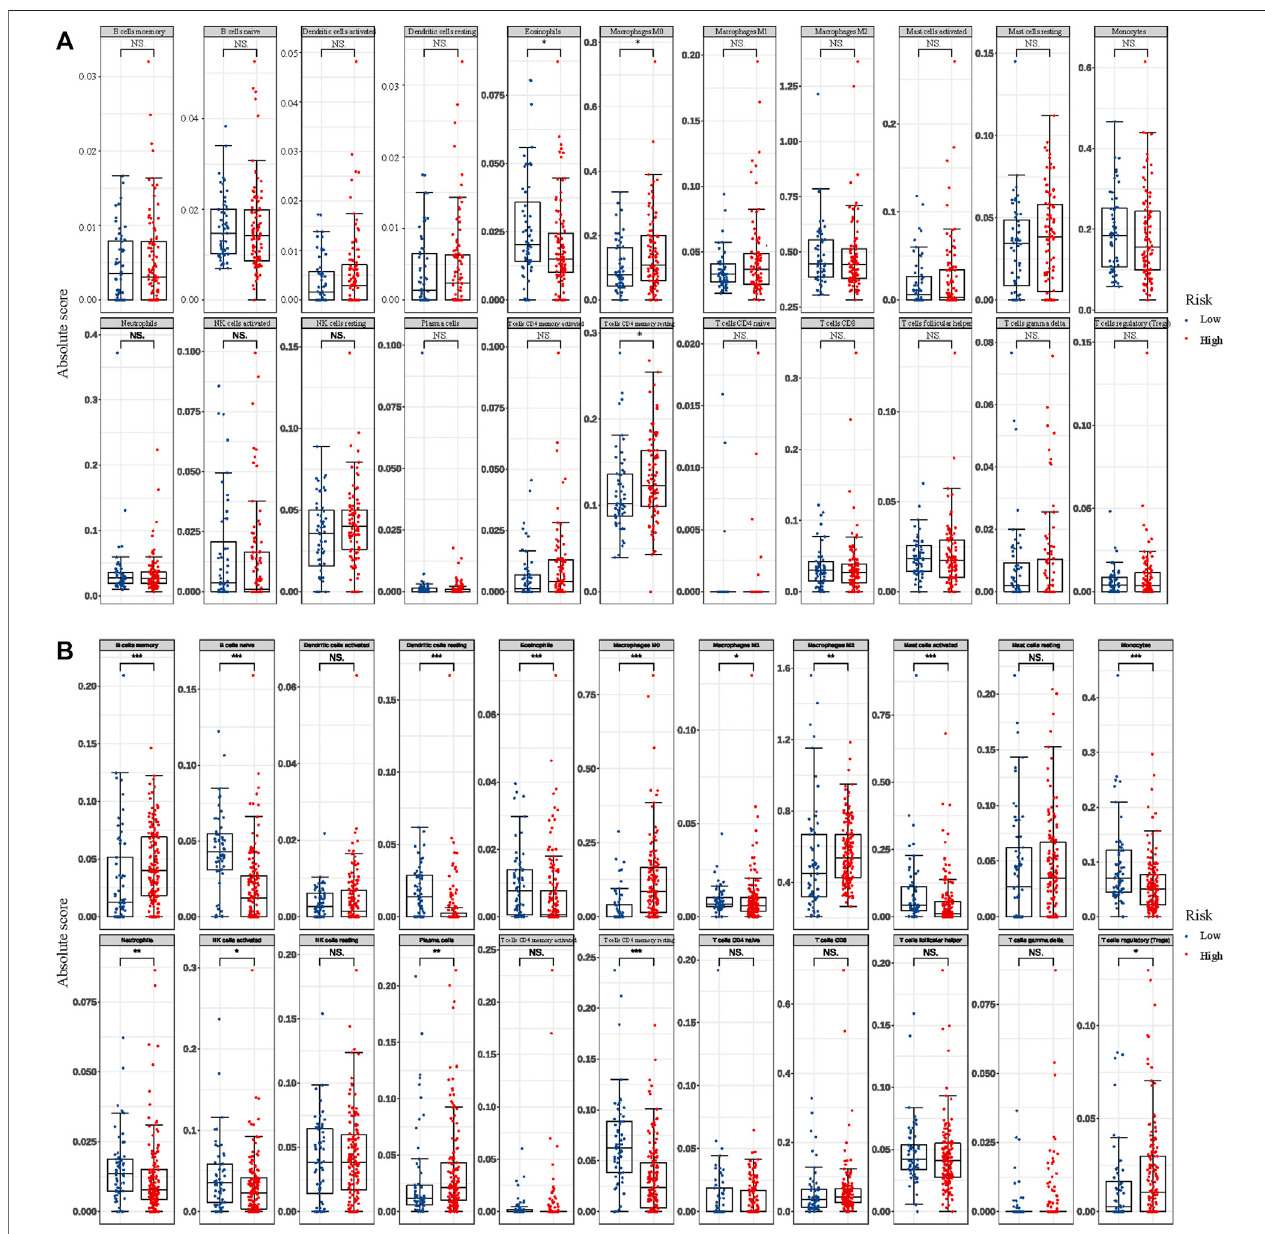
FIGURE 7 | Differential abundances of in fi ltrative immune cells between high- and low-RCN1 groups. (A) TCGA. (B) CGGA.